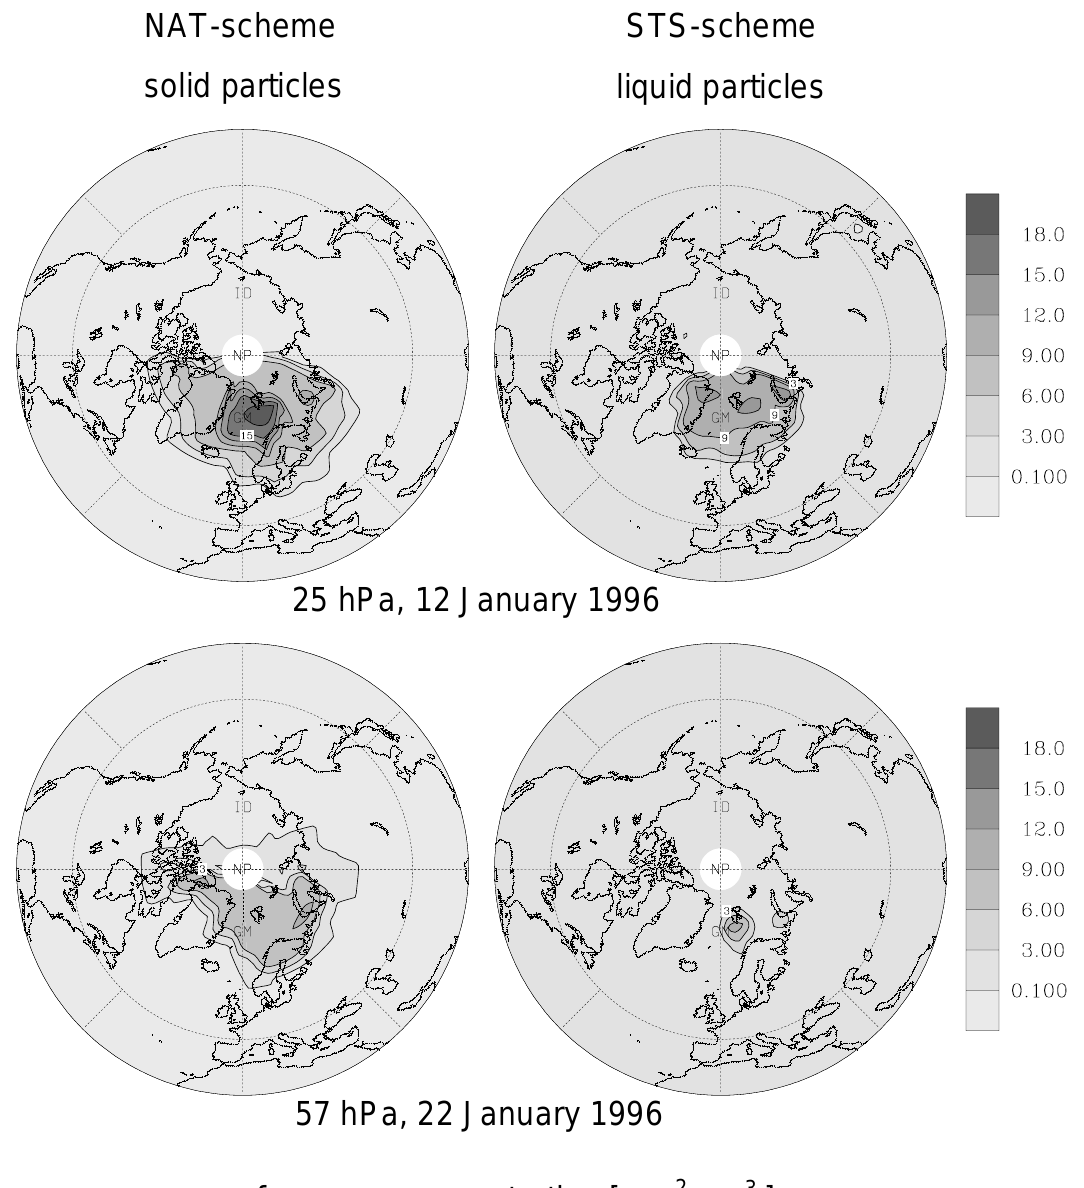
Fig. 4. Surface area concentration ( µ m 2 cm − 3 ) of different particle types modelled for (top frames) the 25 hPa and (bottom frames) the 57 hPa levels. Results are shown for two selected days of January 1996 showing comparatively large PSC activity (57 hPa level on 22 January 1996, and 25 hPa level on 12 January 1996). The left frames show the total solid particle surface area concentration (NAT, SAT and ice particles) modelled applying the NAT-scheme. The right frames present the surface area concentration of liquid particles simulated using the